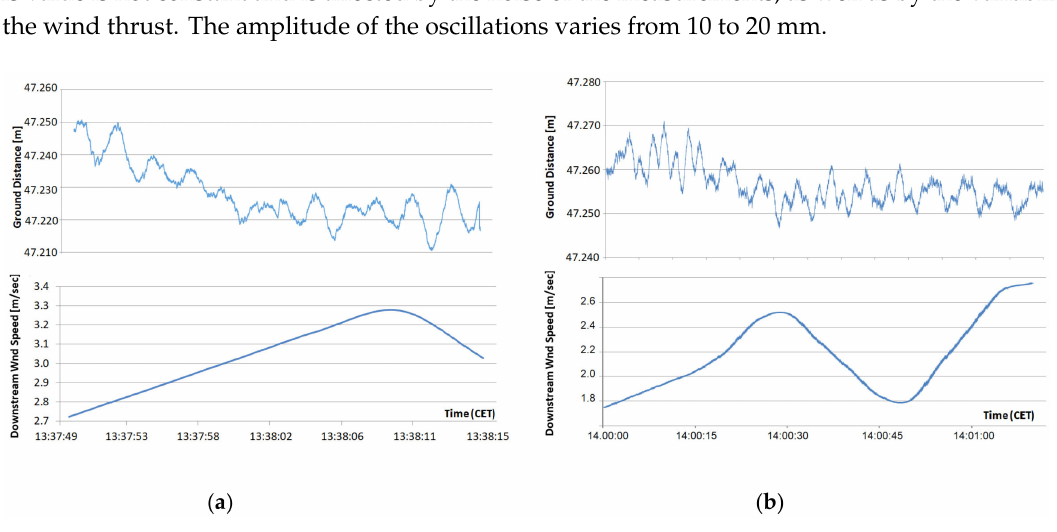
Figure 15. Ground distance from TLS of a point P on the tower located at H = 65 m during the activity of the turbine, from 13:37:50 to 13:38:12 ( a ) and from 14:00:00 to 14:01:06 ( b ). Below the graphics of the distances, the wind speed in m / sec. X axis is the time, both for upper and lower